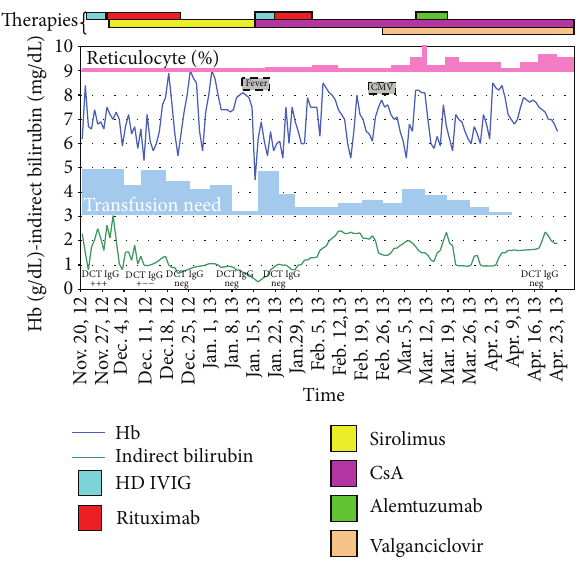
Figure 1: Correlation between therapy and outcome during